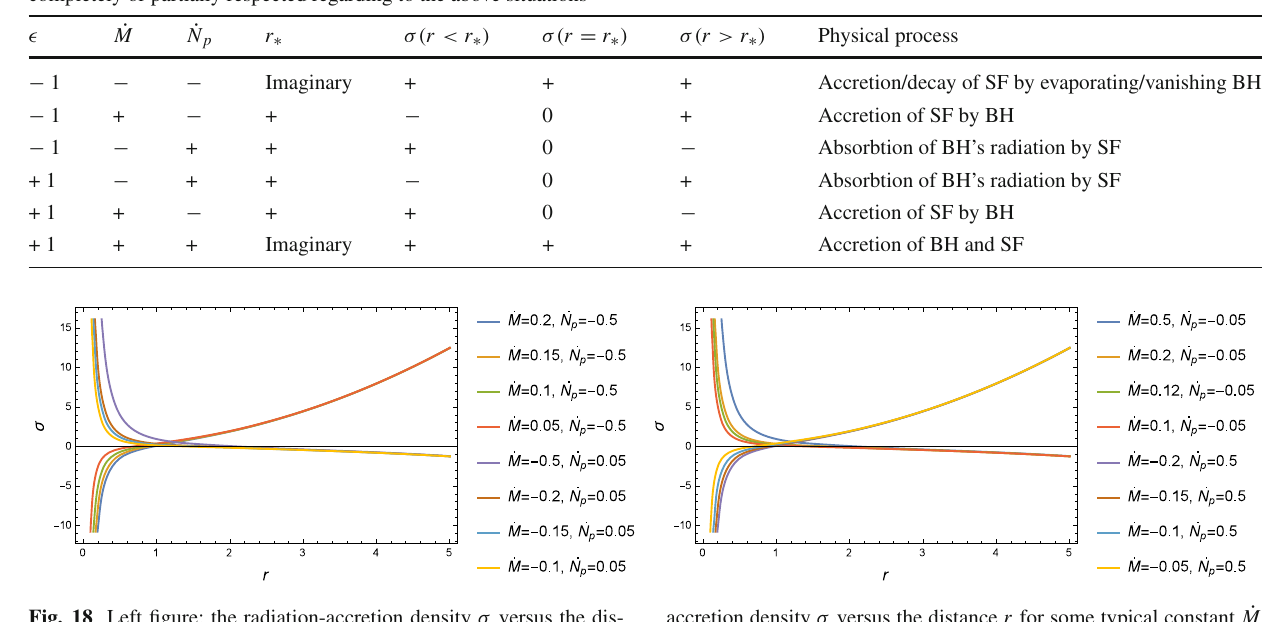
accretion density σ versus the distance r for some typical constant ˙ M and ˙ N p values for (cid:5) = + 1 in the phantom background. In the four upper cases, the accretion density is a decreasing function from pos- itive to negative values. In the four lower cases, the radiation density is an increasing function from negative to positive values. Then, for a dynamical phantom background, if the condition | ˙ N p ( u ) | (cid:11) | ˙ M ( u ) | is not met, the positive energy condition is violated in some regions of spacetime